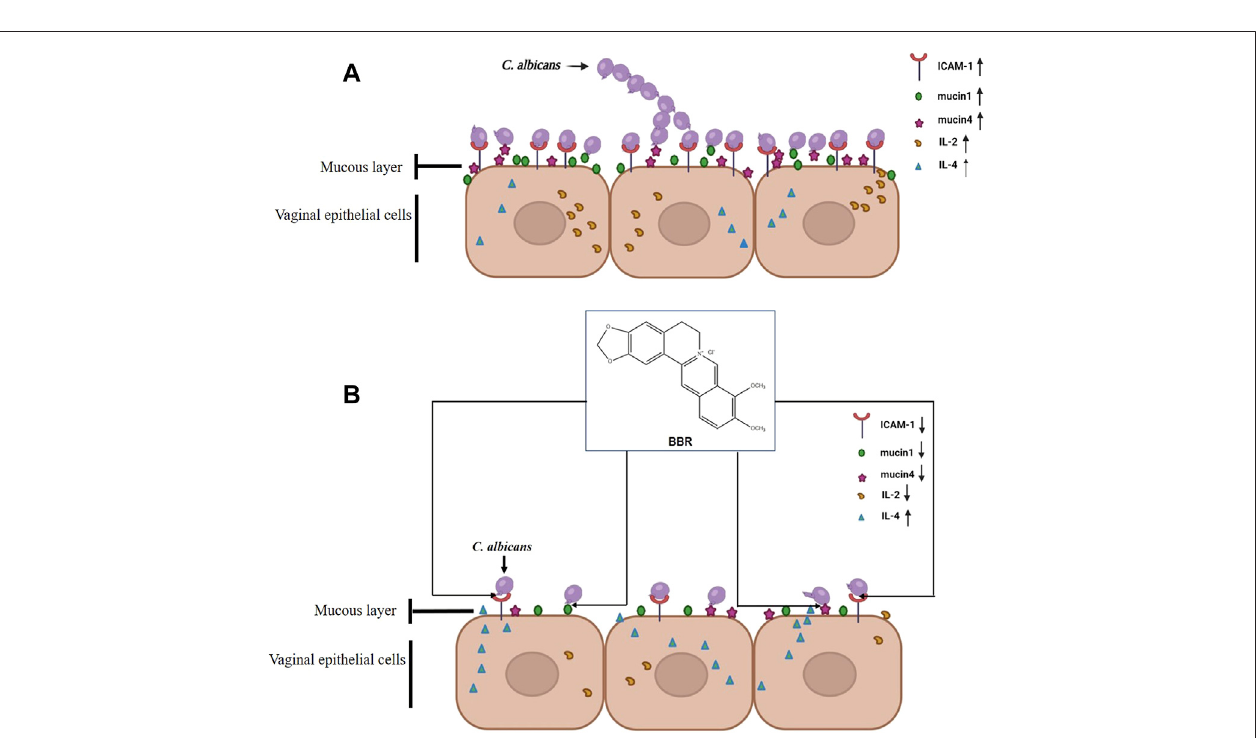
FIGURE7| PossiblemechanismofBBRblockingtheadhesion of C.albicans tovaginalepithelialcellsbyinhibitingtheexpression ofcelladhesionmoleculeICAM- 1, mucin1 and mucin4.